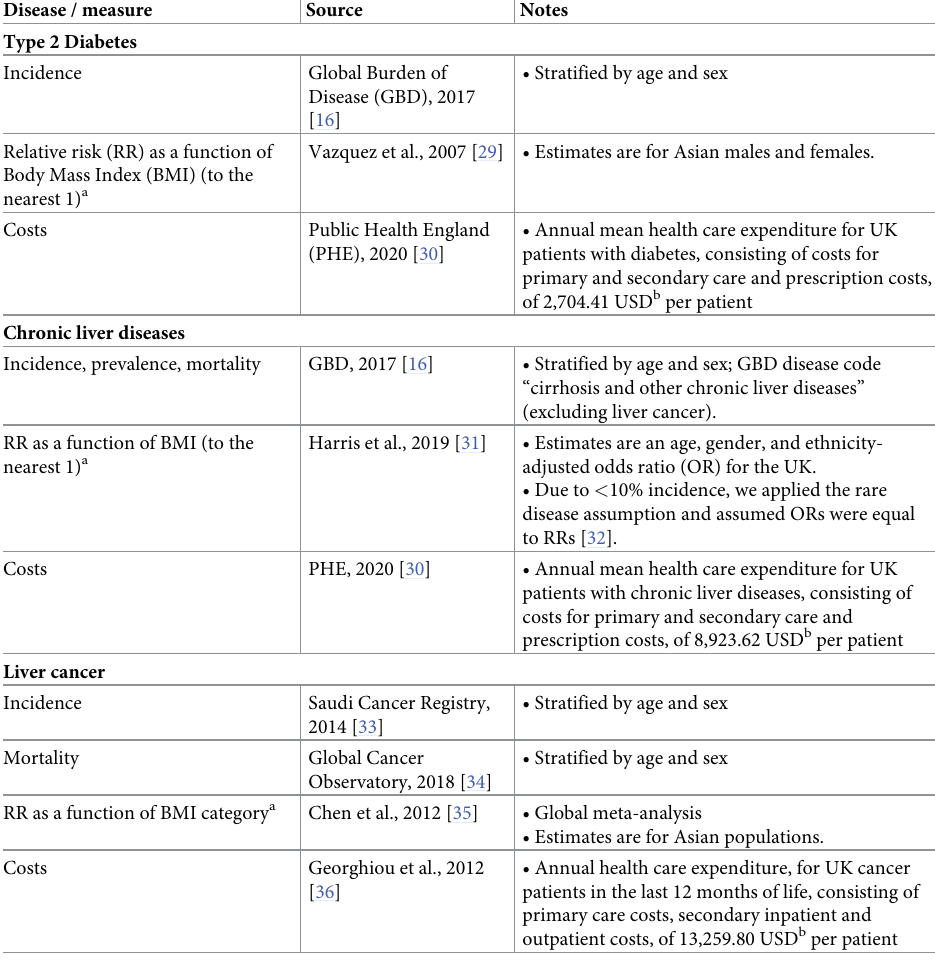
Table 1. Data sources for disease epidemiology and cost data used in the